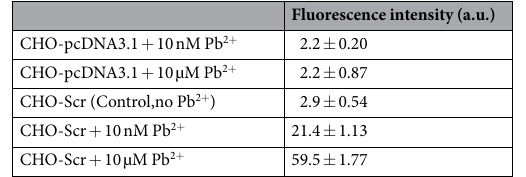
Table 1. Flow cytometric analysis of CHO cell staining with annexin V-FITC. Scr-transfected and mock- transfected cells were grown in the presence or absence of lead, treated with annexin V-FITC, and then analyzed by FACS. Mean values ± S.D. (n = 3).